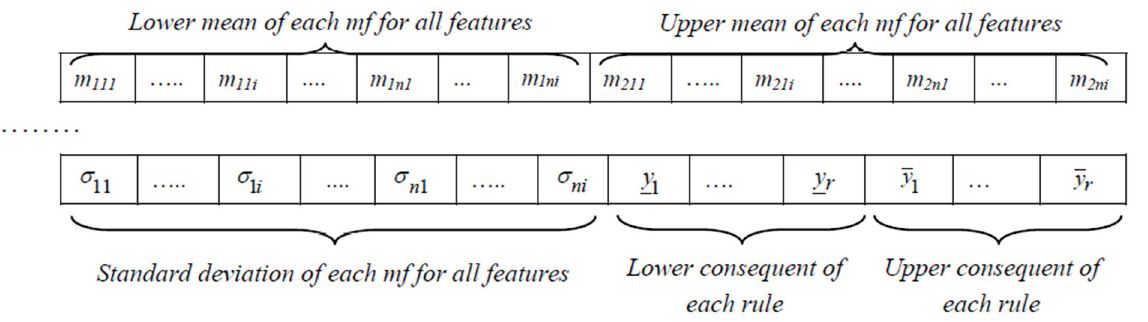
Figure 4. The scheme of the Pittsburg evolution coding of a T2